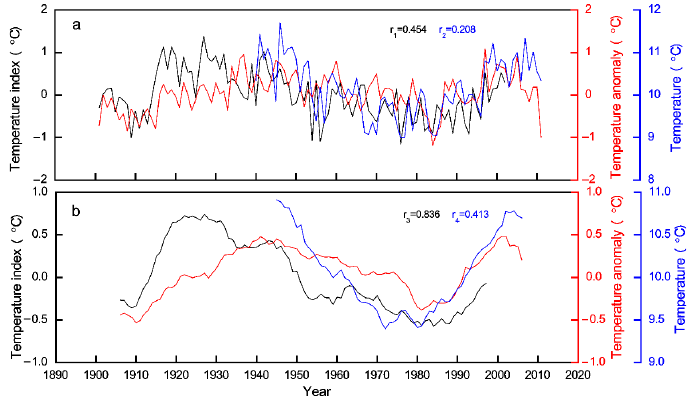
Figure 9. Comparison between the reconstructed T DS (red) and the observed (black) T DS of the Anxi station and the temperature index in north-central China (blue) [48]. ( a ) raw data; ( b ) 11-year aver- age data. r 1 and r 3 represent correlation coefficients between the reconstructed T DS and the observed (black) T DS of the Anxi station on interannual and interdecadal scale, respectively; r 2 and r 4 represent correlation coefficients between the reconstructed T DS and the temperature index in north-central China on interannual and interdecadal scale, respectively.